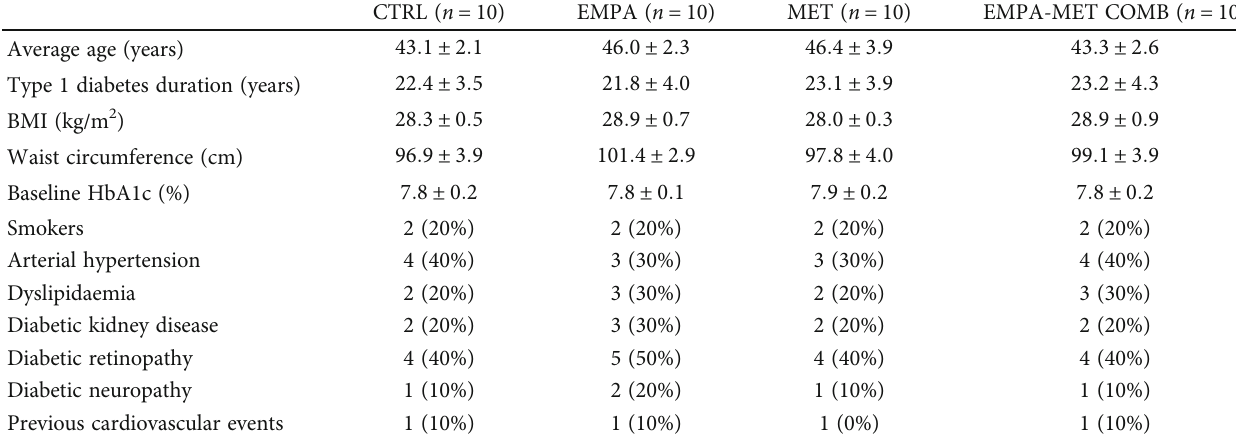
Table 1: Baseline characteristics of the participants at inclusion to the study according to the study groups: control group (CTRL), empagli fl ozin 25 mg daily group (EMPA), metformin 2000 mg daily group (MET), or empagli fl ozin-metformin combination group